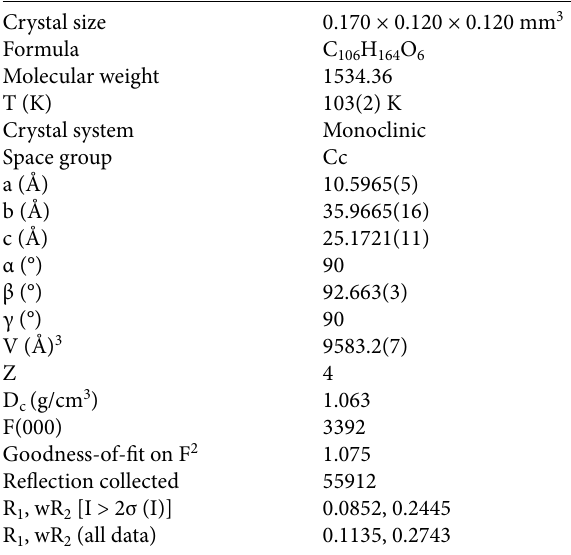
Table 1. Crystal data of the